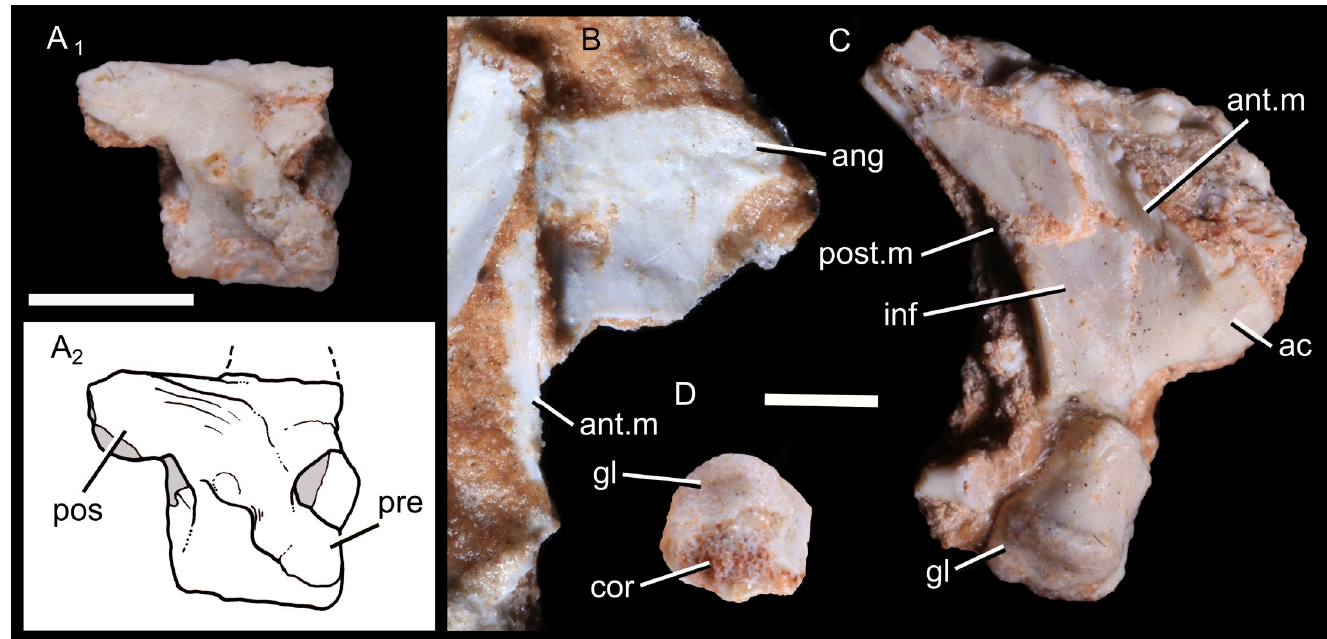
Fig 2. Vertebra and scapula of Brasilodon quadrangularis (UFRGS-PV-1043-T). A , photography (1) and drawing (2) of a fragmented vertebra; B , photography of the possible dorsal part of the right scapula, in medial view; C , photography of the ventral part of the right scapula, in lateral view; D , photography of the glenoid, in distal view. Abbreviations: ac , acromion; ang , posterodorsal angle; ant.m , anterior scapular margin; cor , area of contact with the coracoid; gl , scapular glenoid facet; inf , infraspinous (supracoracoideus) fossa; pos , postzygapophysis; post.m , posterior scapular margin; pre , prezygapophysis. Scale bar = 2 mm.